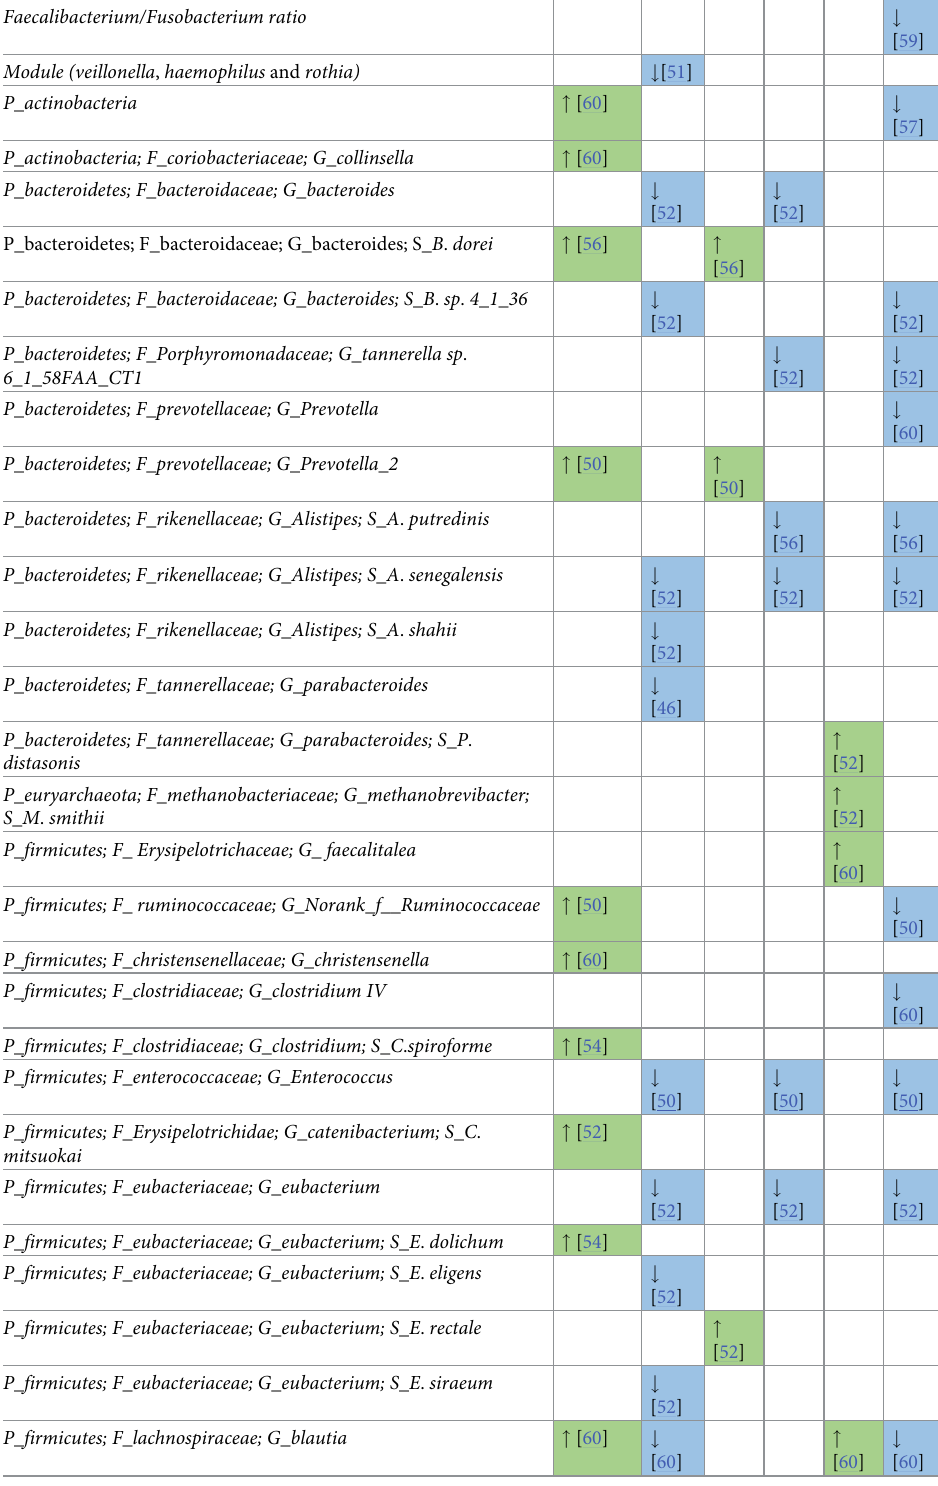
Table 5. Correlations between specific bacteria and host glucose parameters.